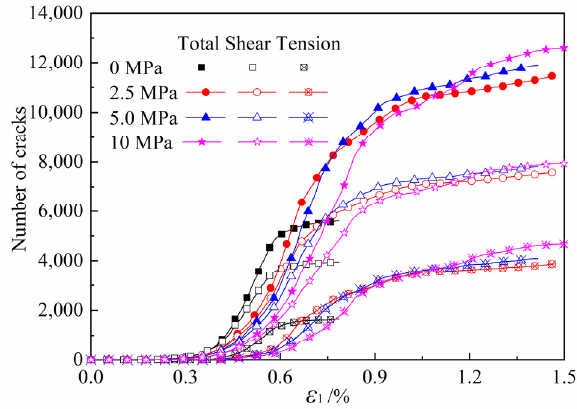
Figure 15. Growth process of crack number in RAC20 under different confining pressures.